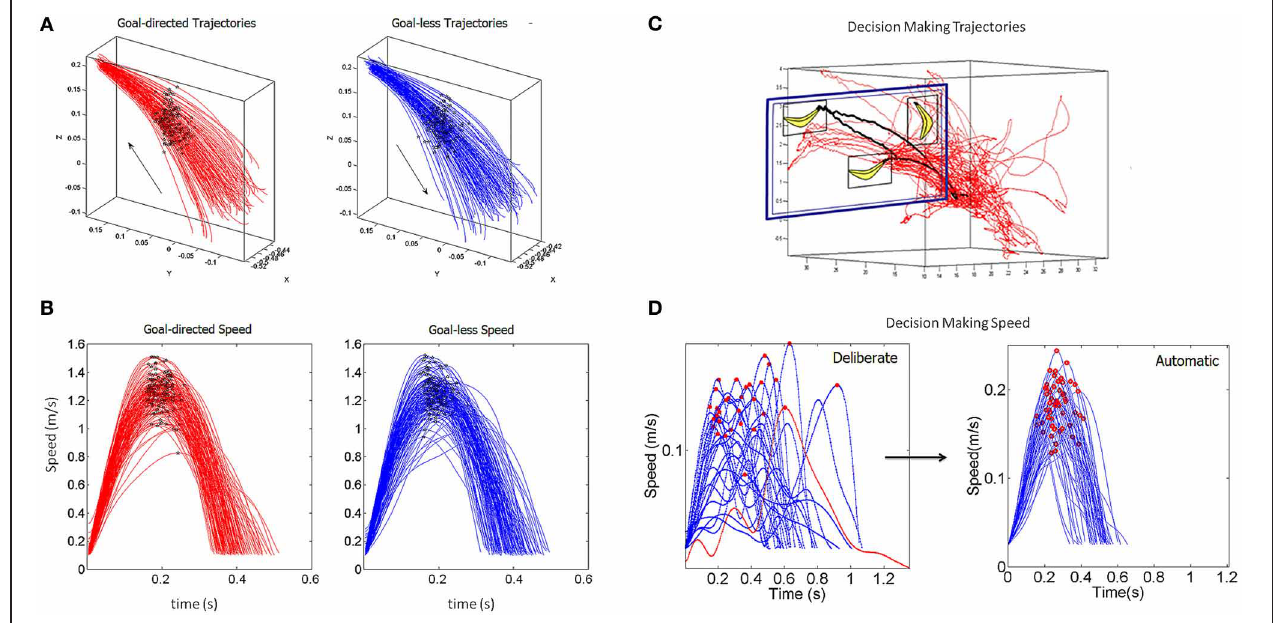
FIGURE 5 | Sample hand trajectories and speed profiles from the two variants of the pointing task. (A) Forward movements to the goal and incidental goal-less segments of the basic pointing task performed by an adult participant. The arrow marks the direction of the movement. The stars mark the spatial location of the peak velocity along the trajectories. (B) The corresponding instantaneous speed profiles along the trajectories in (A) . Notice that these are deceptively similar as the differences lie in their stochastic signatures across trials. (C) Decision-making hand